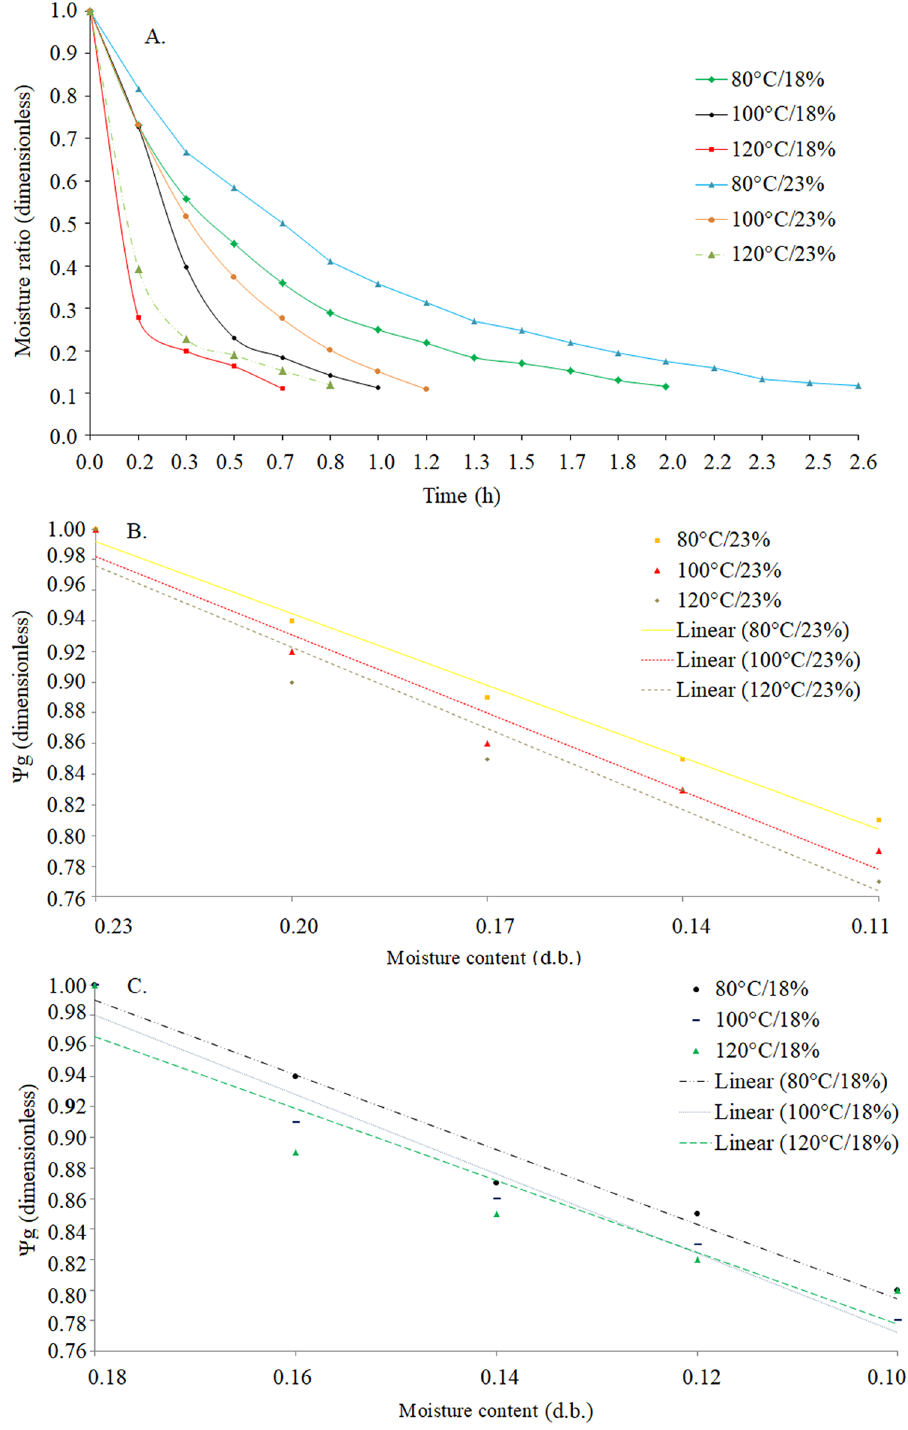
Figure 2. Moisture content adjusted by the Wang & Singh model ( A ), volumetric shrinkage of soybeans in the drying using the model of Rahman, at initial moisture content of 23% (d.b.) ( B ) and 18% (d.b.) ( C